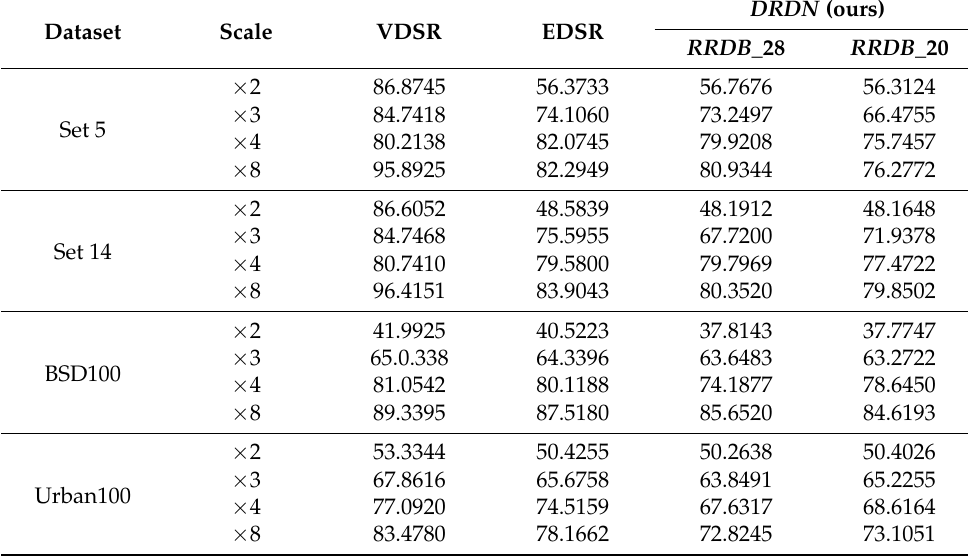
Table 2. Perceptual evaluation based on benchmark datasets (perception-based image quality evalua- tor ( PIQE